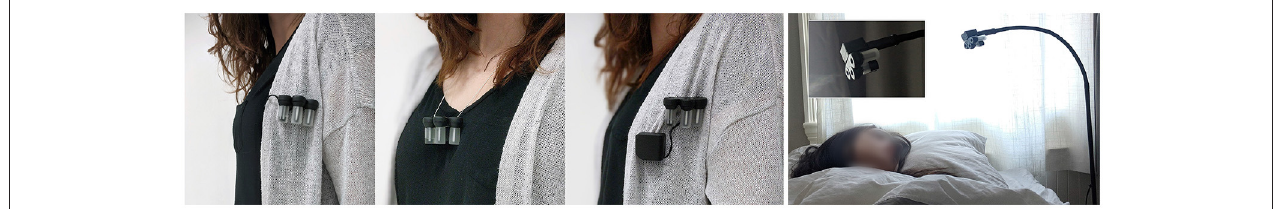
FIGURE 3 | Ezzence can be worn during the day and be attached to a bedside holder at night. It can also hook onto pajamas, blankets, necklaces or, inspired by a brooch; each part can be attached separately. The custom holder charges the device and has an adjustable flexible neck. It wirelessly connects to the smartphone application that controls the duration and frequency of the scent bursts and activates odors depending on physiological signals, sleep stage, and the user’s